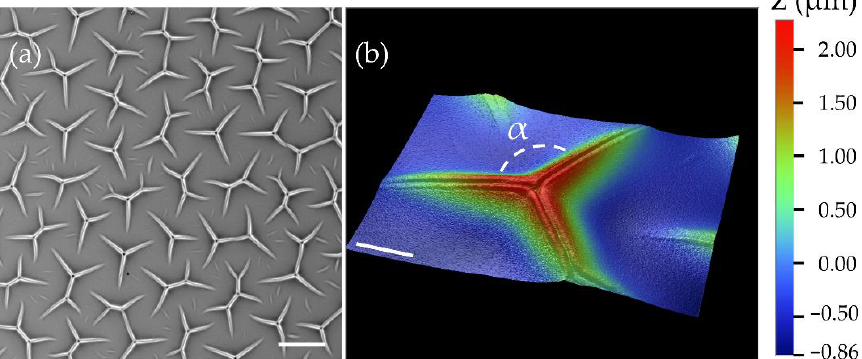
Figure 1. Representative microscope images of the gel substrates with surface instabilities. ( a ) A brightfield image (scale bar: 100 µm). ( b ) A 3D surface profile of an instability feature measured with a white-light interferometer (scale bar: 20 µm).